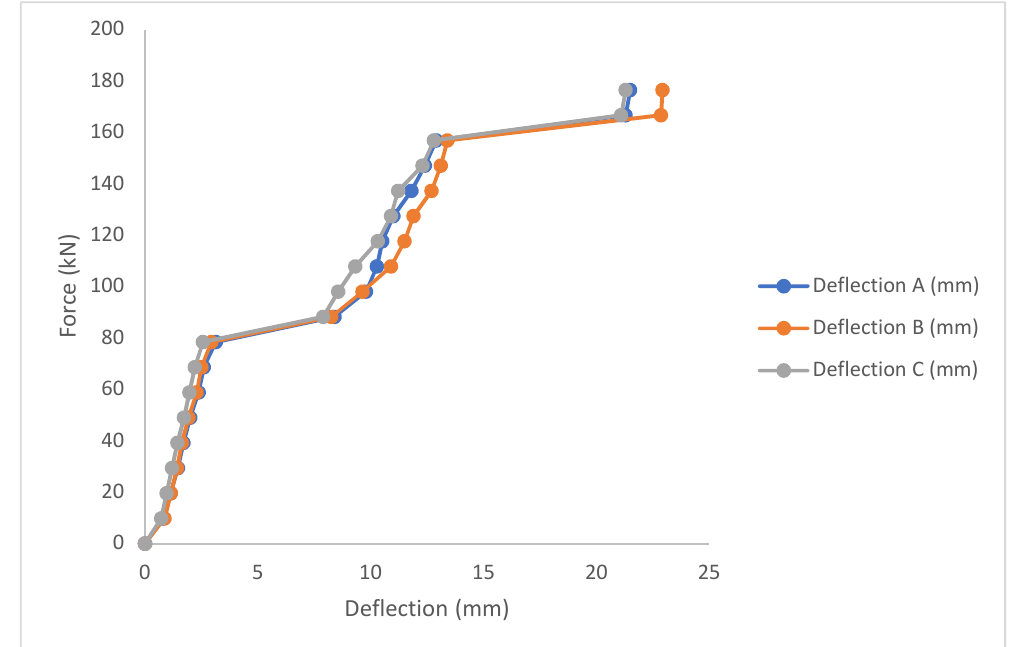
Figure 9. Load deflection plot for control beam.